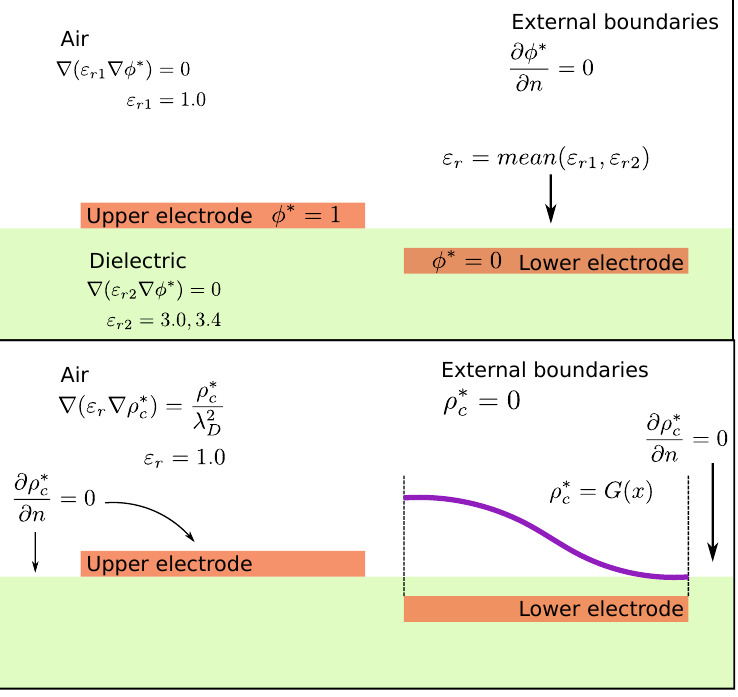
Figure 3. Boundary conditions for the Suzen